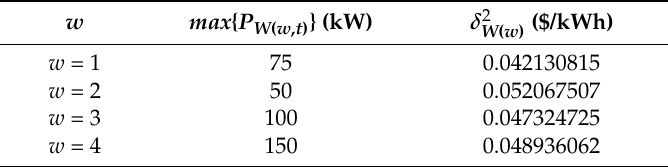
Table 3. Characteristics of distributed wind